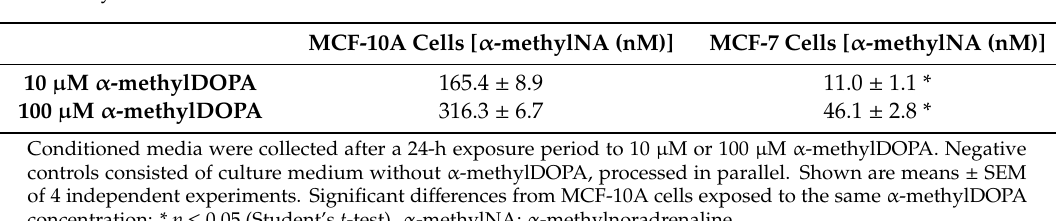
Table 2. Capacity of non-tumorigenic (MCF-10A) and tumorigenic (MCF-7) breast cells to metabolize α